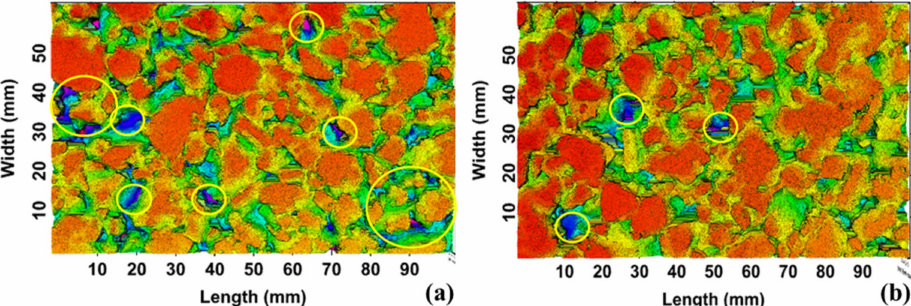
Figure 12. The 3D models of pavement: ( a ) CC, ( b )